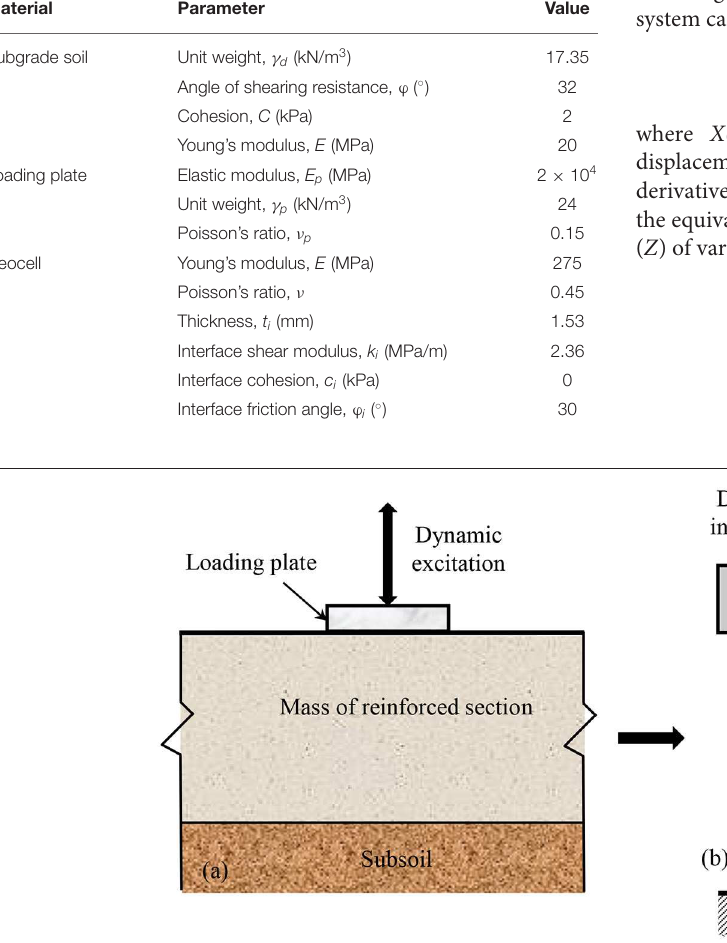
Frontiers in Built Environment |